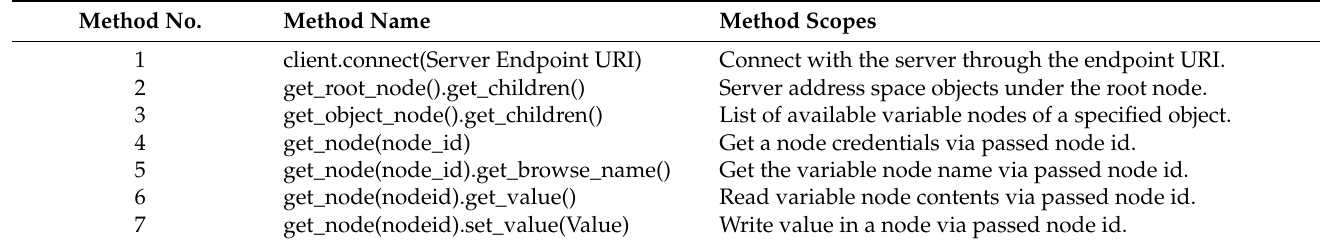
Table 2. List of key methods used to develop the middleware